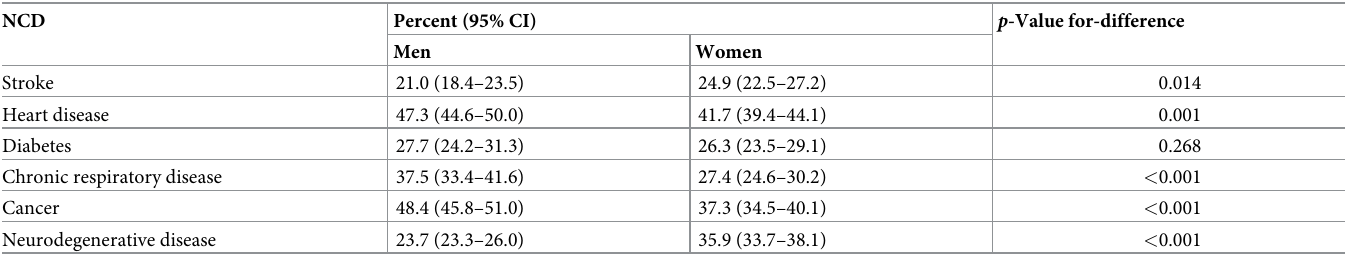
Table 2. Lifetime risks for each NCD separately, stratified by sex.